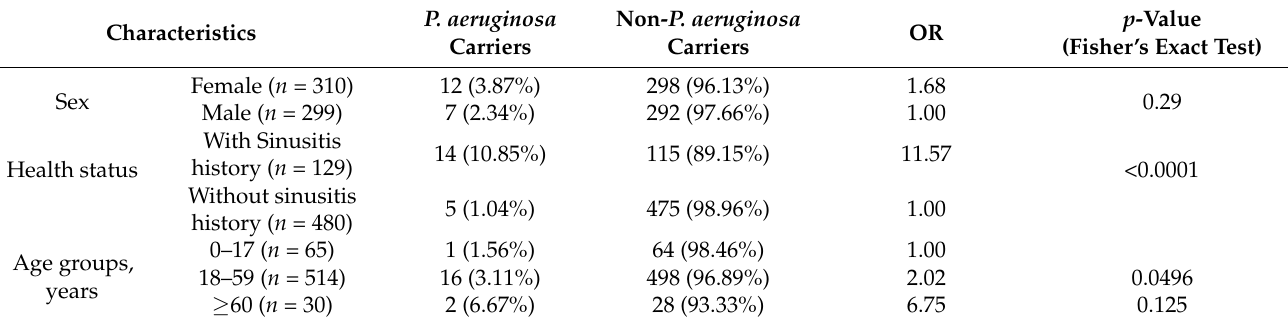
Table 2. Odd ratio (OR) for sex, age, and health status differences in P. aeruginosa carriers.